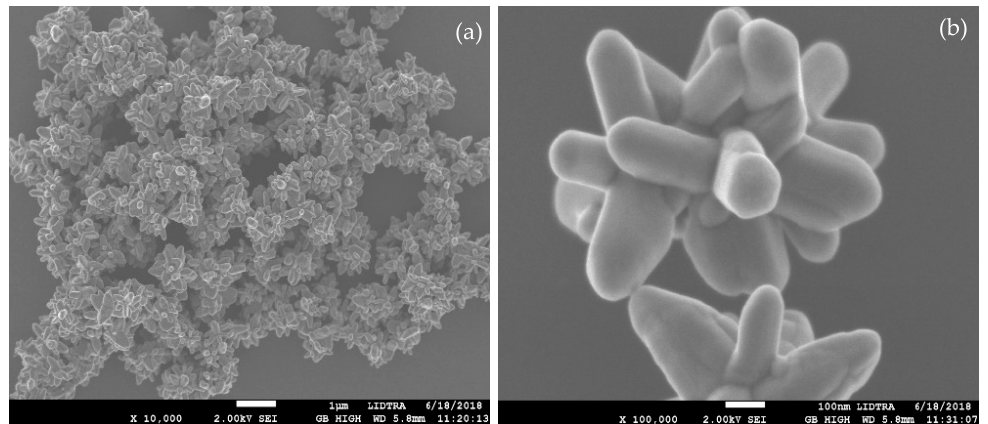
Figure 6. ( a ) Field emission scanning electron microscopy (FESEM) image of synthesized flower-shaped ZnO nanostructures; and ( b ) a high magnification image of a single flower.